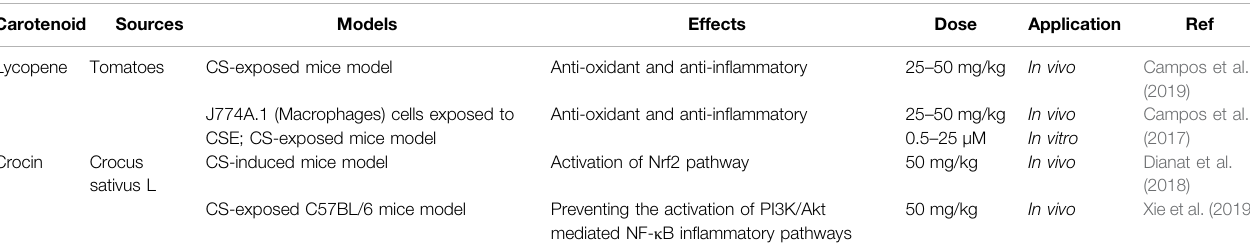
TABLE 9 | The effects of carotenoids on